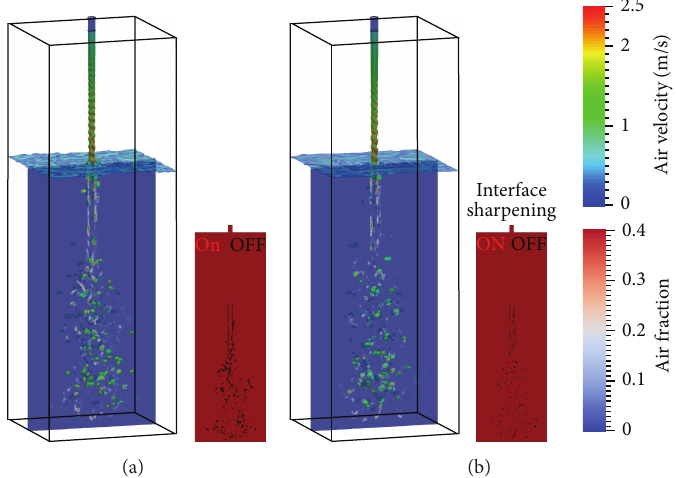
Figure13:Bubbleplumeat 𝑡 = 1 .25 sontherefinedmeshshowingresolvedbubbles(3Dsurface,coloredbyvelocitymagnitude)anddispersed gas fraction distribution on cross-sectional plane for (a) rPBE and (b) We =